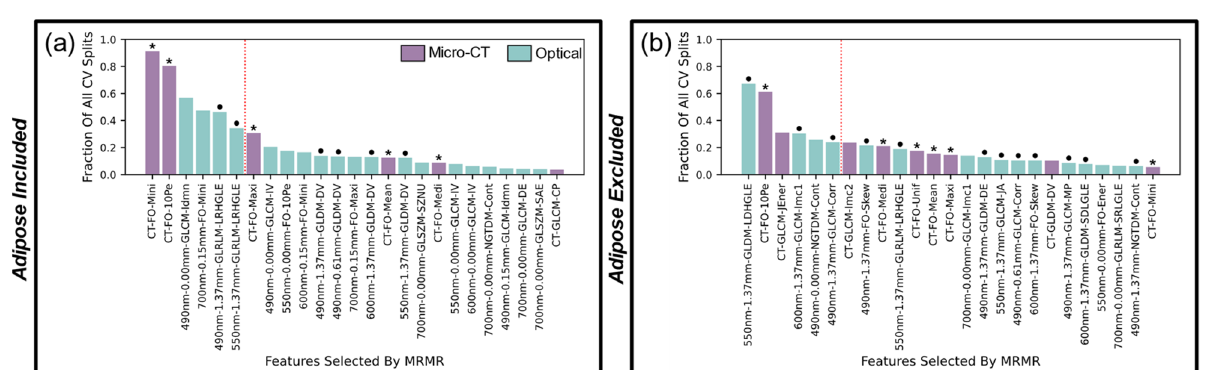
Figure 3. Most frequently selected features by MRMR using combined radiomic/optomic features derived from 5 × 5 mm sub-image samples when adipose tissue samples were ( a ) included and ( b ) excluded. These subplots relate directly to classification performances shown in Fig. 2c,f, respectively. Vertical axes signify the fraction of all n = 1000 Monte Carlo CV splits that MRMR selected each feature. Asterisks (*) signify first-order micro-CT features. Dots (•) signify high spatial frequency (0.61 or 1.37 mm −1 ) reflectance, SFDI-derived features.